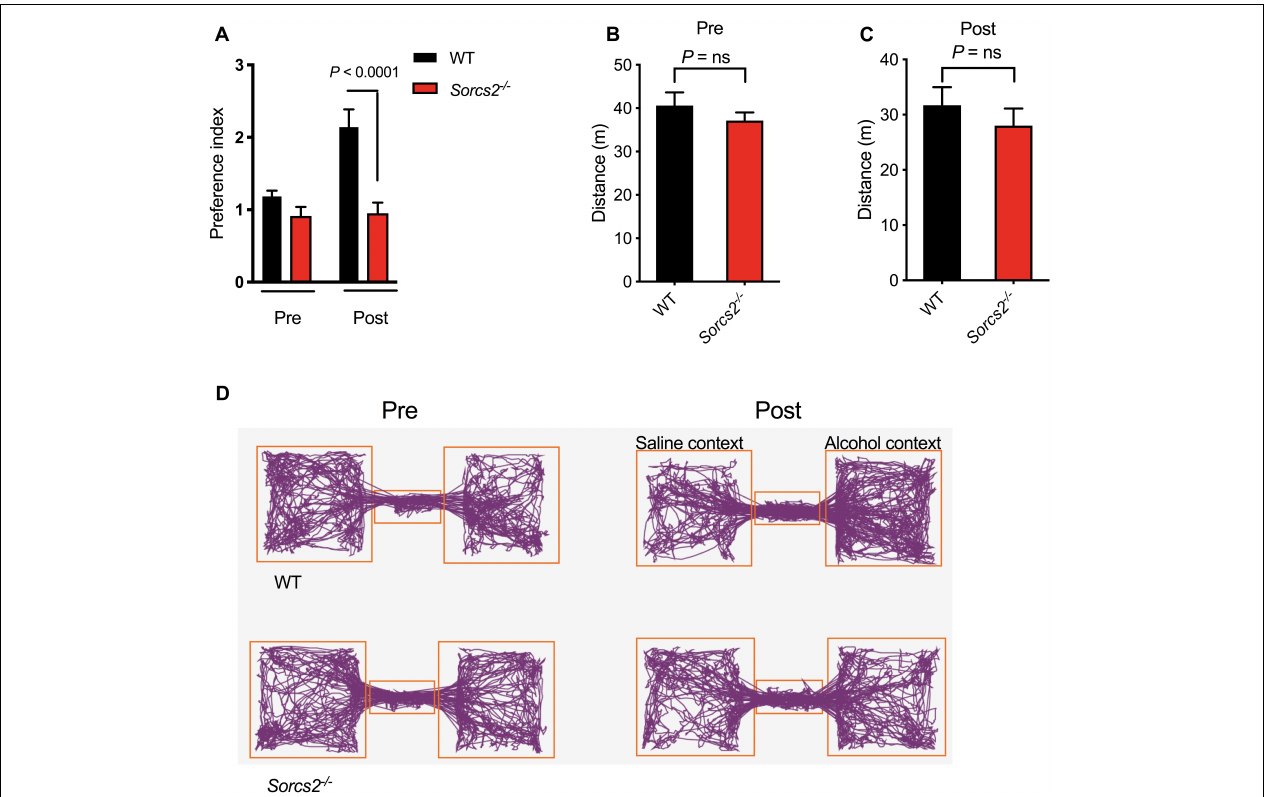
FIGURE 1 | Lack of alcohol-induced place preference in Sorcs2 − / − mice. (A) Preference index for WT and Sorcs2 − / − for the alcohol conditioned context over the non-conditioned context, showing there was a significant difference between WT and Sorcs2 − / − mice in acquiring alcohol-induced place preference ( P < 0.0001). (B,C) Activity before (Pre) and after alcohol conditioning (Post), showed no significant difference in activity between the two genotypes ( P = 0.63 for both). (D) Track plots illustrating activity in the three compartments of the preference box before and after alcohol conditioning ( n = 6 for WT and n = 10 for Sorcs2 − / − ).